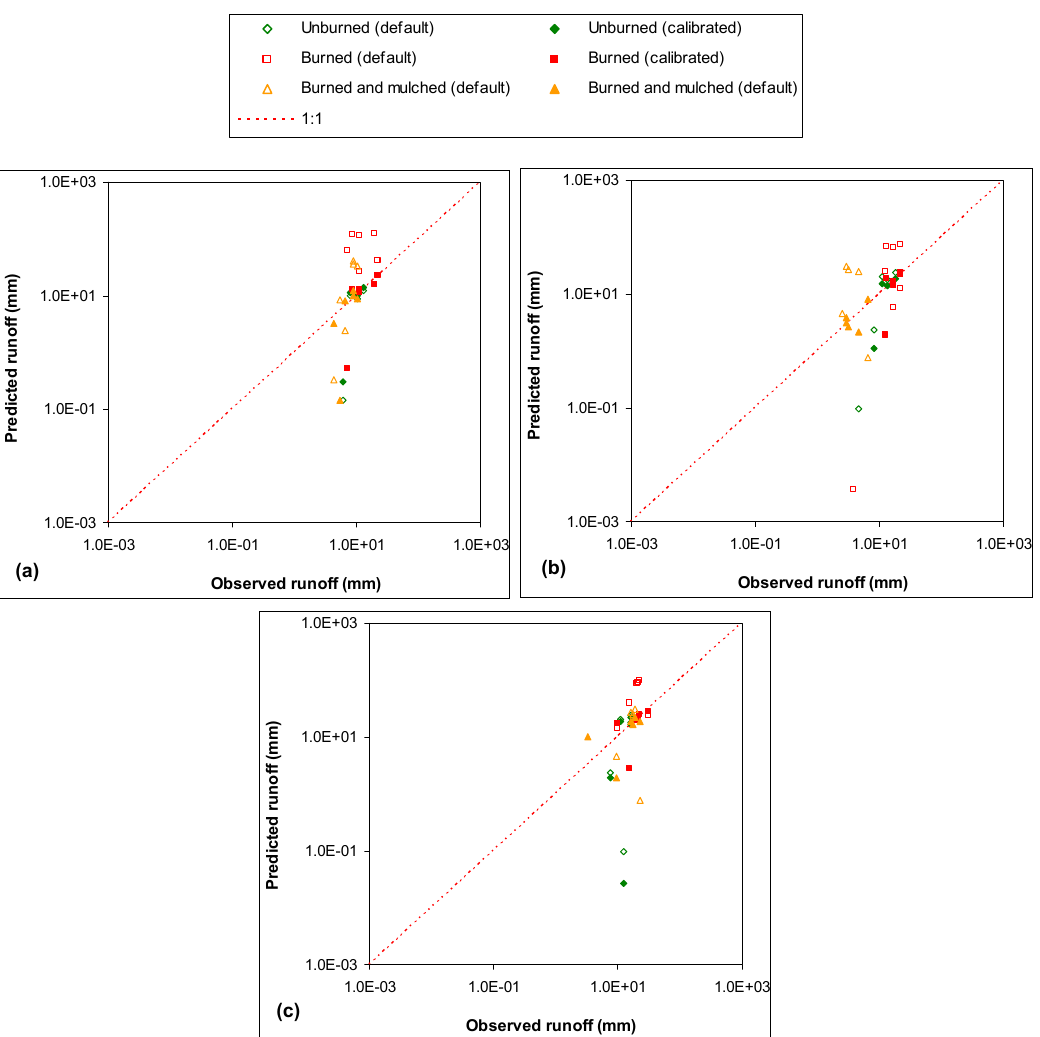
Figure 5. Scatter plots of runoff volumes observed in forest sites (( a ), pine; ( b ), chestnut; ( c ), oak) subject to prescribed fire and soil mulching with fern vs. predicted using the SCS-CN model. Values are reported on logarithmic scales.